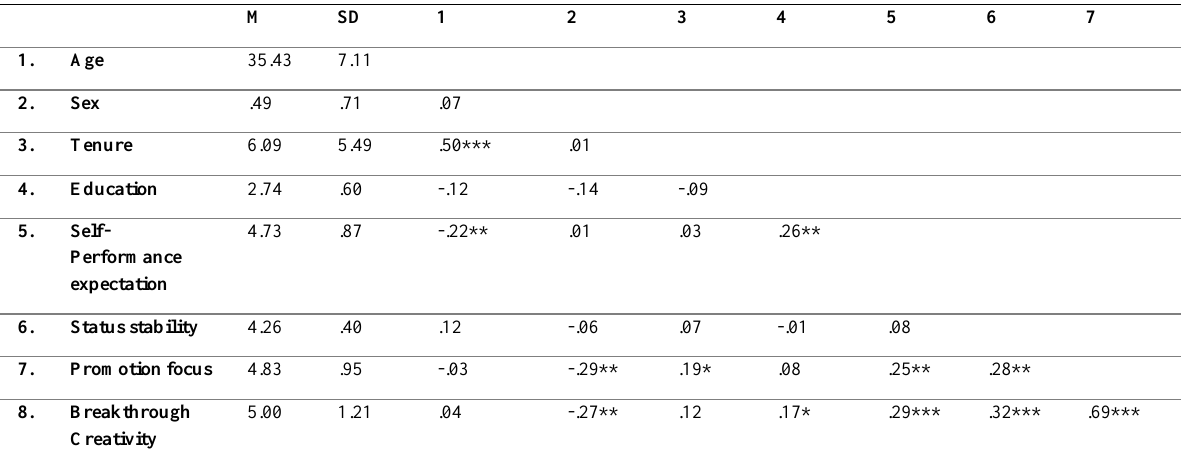
Table 1: Means, standard deviations, and correlations among study variables